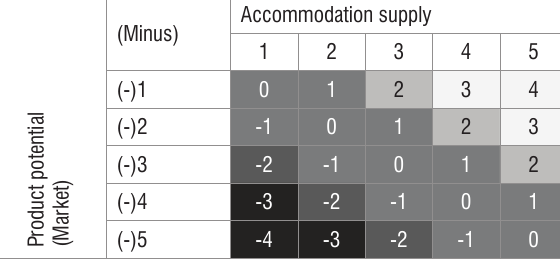
Figure 5: Calculation methodology for the gap between tourism potential and tourism resource provision.